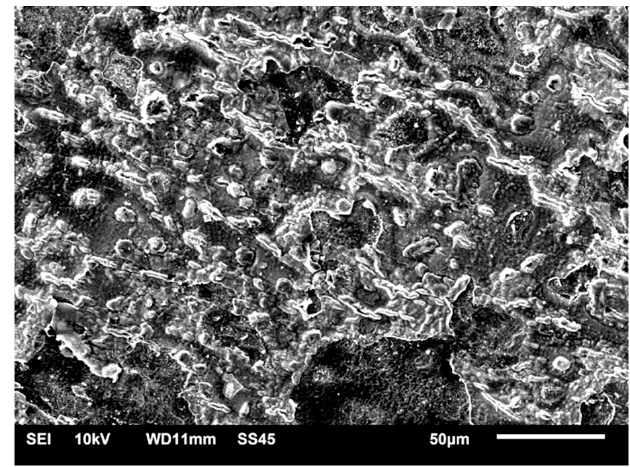
Figure 6. SEM-SE surface morphology of casted MC-HT (×500).